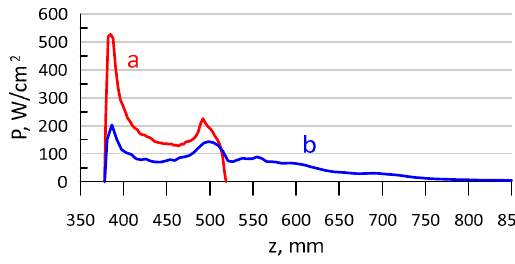
Figure 1. Power density dissipated in the collector: (a) without secondary emission and (b) with secondary emission taken into account.